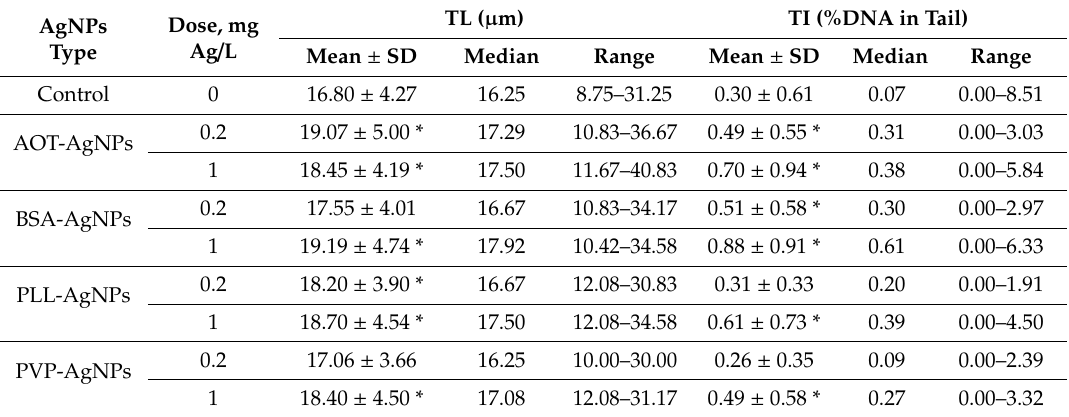
Table 3. Results of Comet assay in lymphocytes treated with AOT-, PVP-, PLL- and BSA-coated AgNPs for 3 h. Obtained parameters, tail length (TL) and tail intensity (TI), are expressed as mean values including SD, medians and ranges. Results are obtained from 6 independent experiments. Statistically significant di ff erence are denoted with asterisk (*) for the mean TI and TL values of treated compared to non-treated control cells at the p < 0.05.